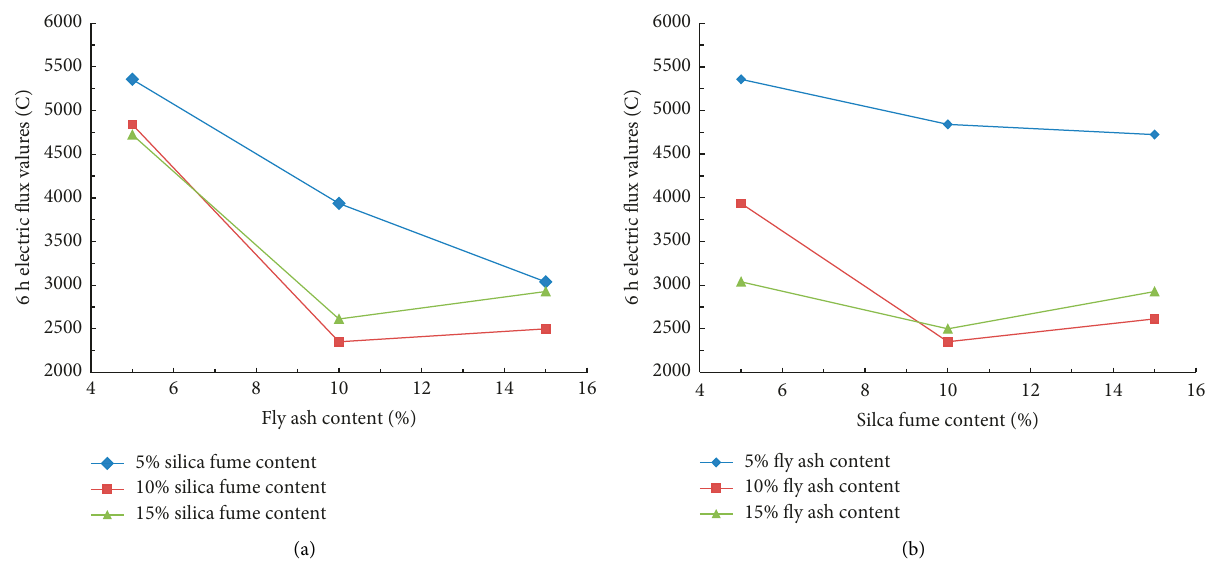
Figure 13: Influence of fly ash and silica fume on the chloride penetration resistance of MPPF coral concrete. (a) Influence of fly ash content on electric flux of concrete for 6 h. (b) Influence of silica fume content on electric flux of concrete for 6 h.